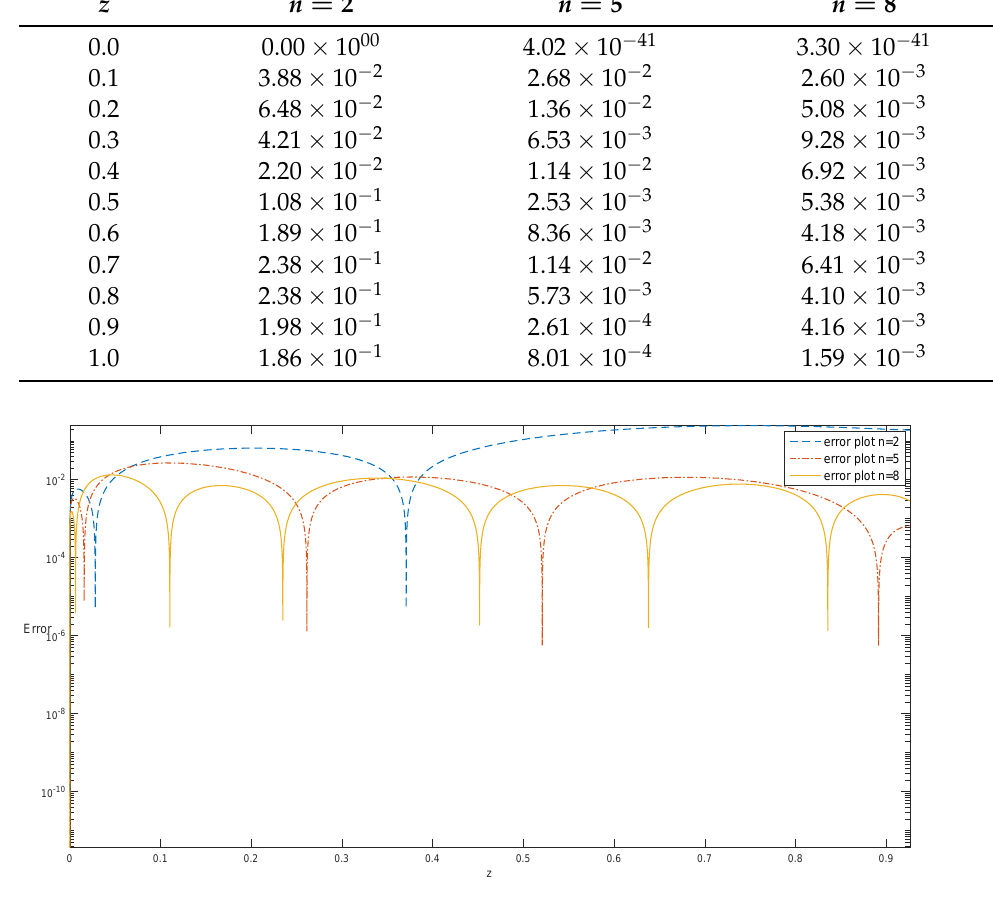
Figure 4. Error plots of Example 4 at different scale levels.